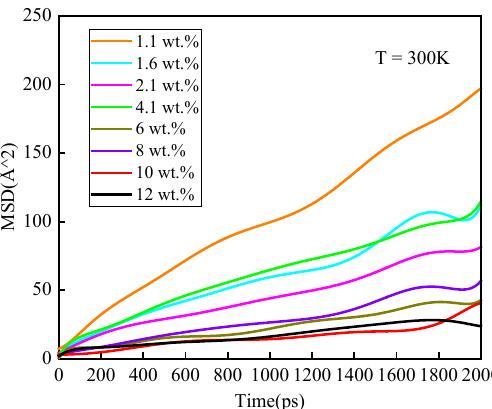
Figure 9. Mean square displacement of water molecules for various moisture concentrations.